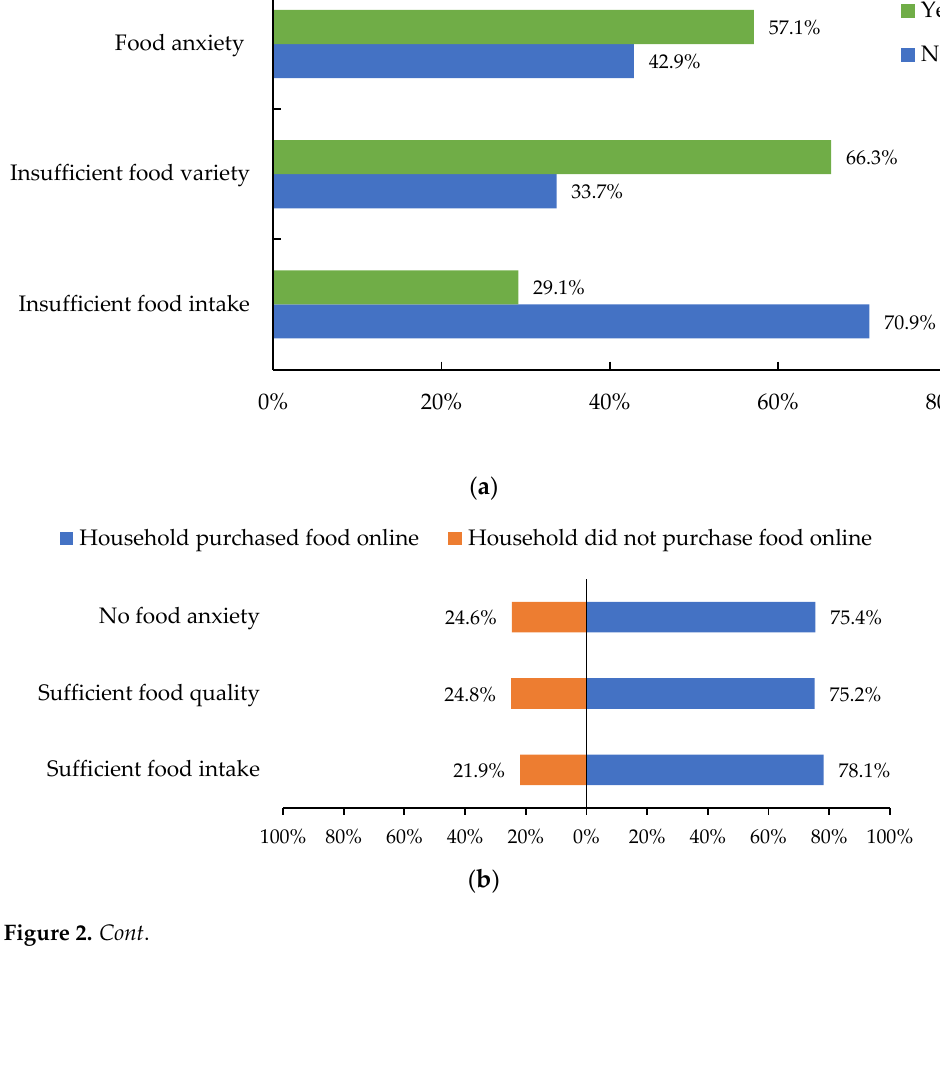
Household did not purchase food online Figure 2. Cont